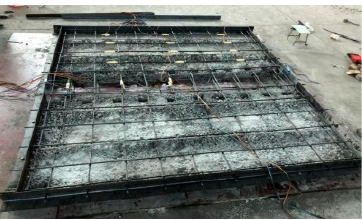
Figure 5. The reinforcement of post − cast layer of composite slab.